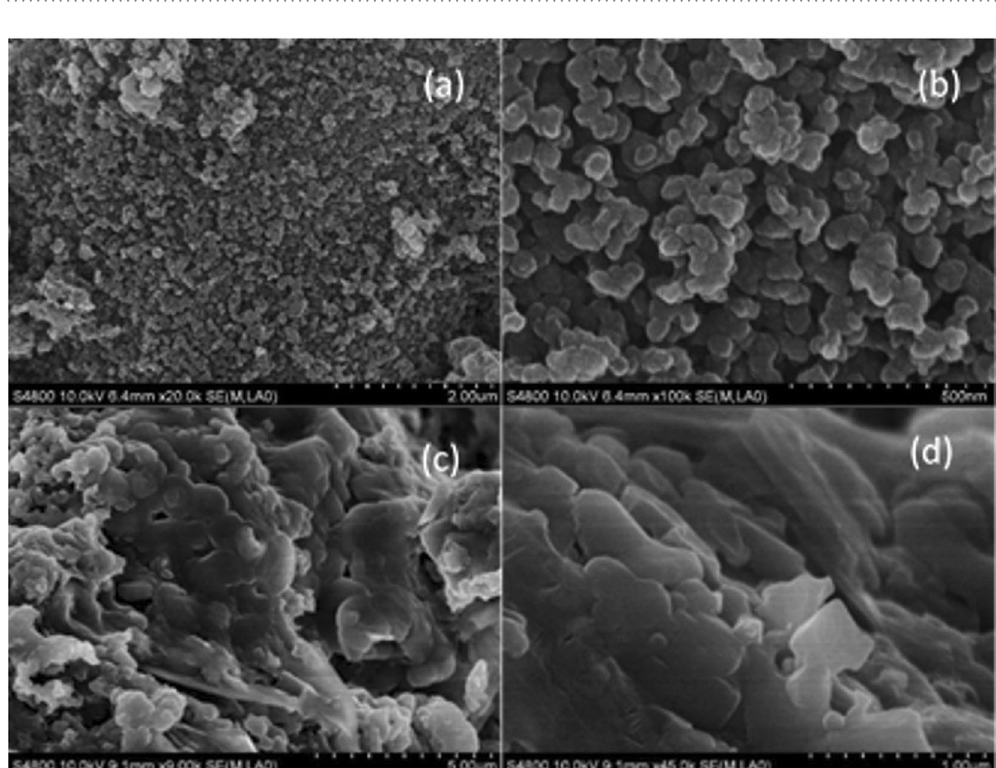
Figure 2. SEM images of BFH-850 ( a , b ) and BF-850 ( c , d